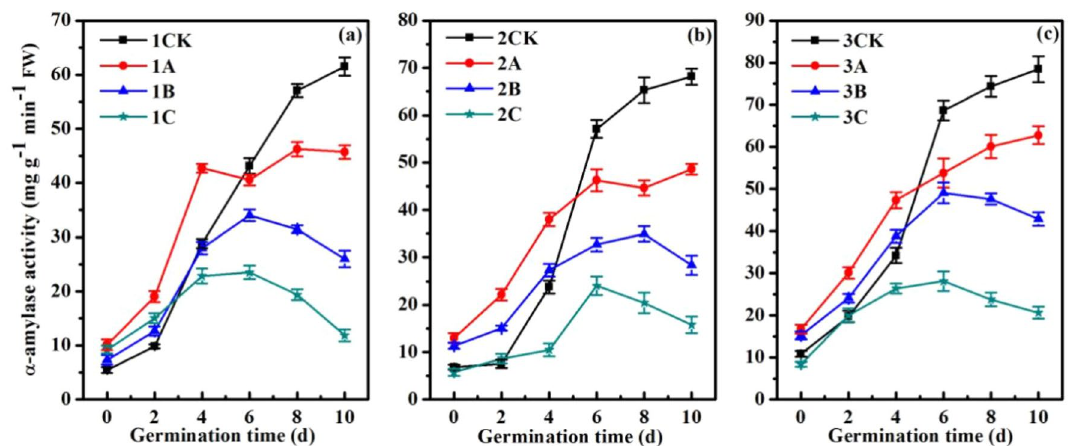
Figure 2. α-Amylase activity of rice seeds as a function of time in ( a ) XD10-01 ( ♀ ), ( b ) BX10 ( ♂ ), and ( c ) XJ (04)-08 under various doses of N ion beam irradiation. The means (± SEs) were calculated from three replicates per